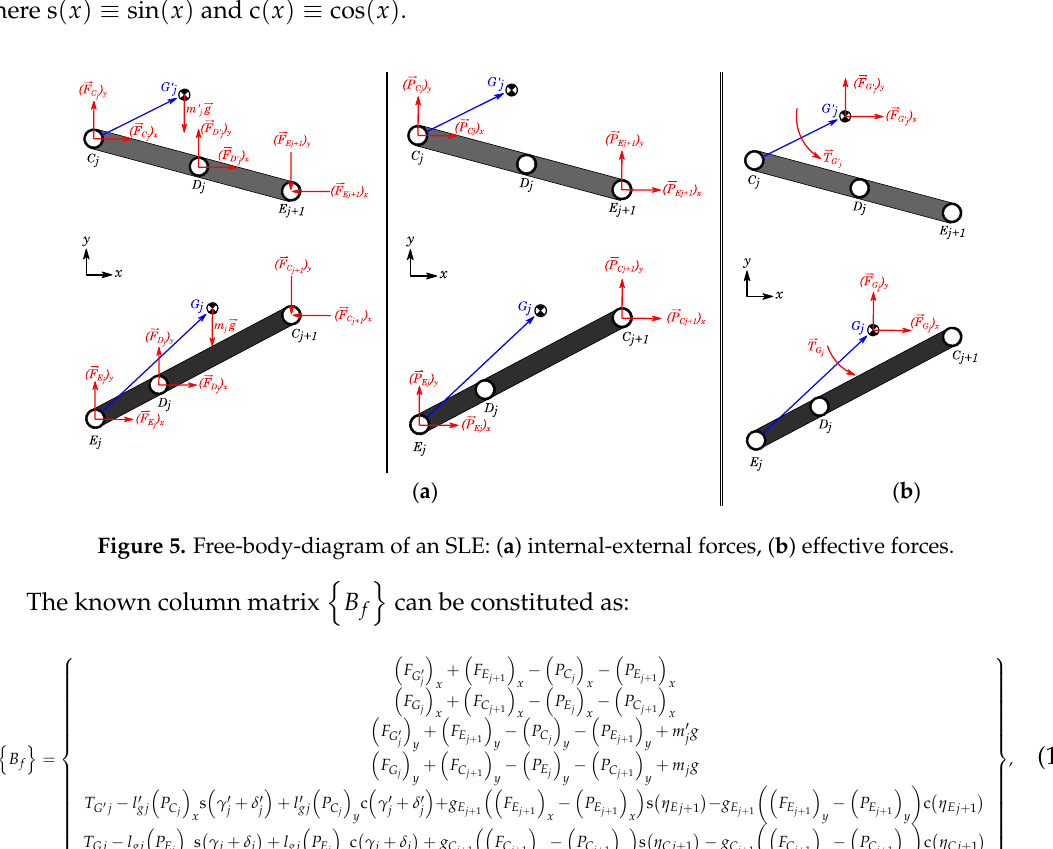
Figure 4. Representation of the arbitrary locations of mass centers of a generic SLE.